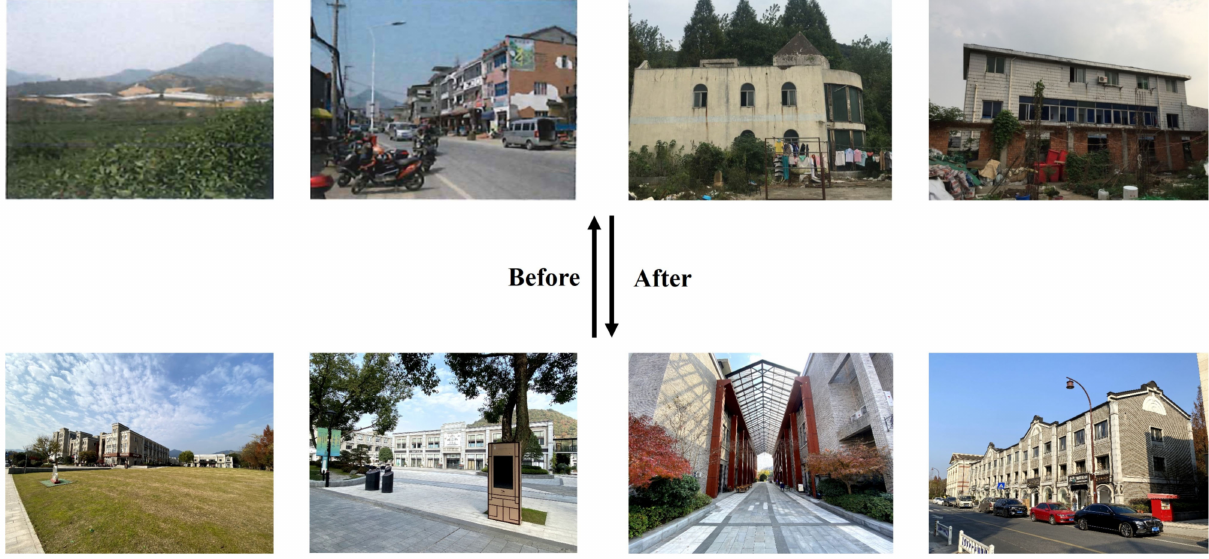
Figure 3. Scenes of the area where WLLTT is located before and after the CT development (source: authors’